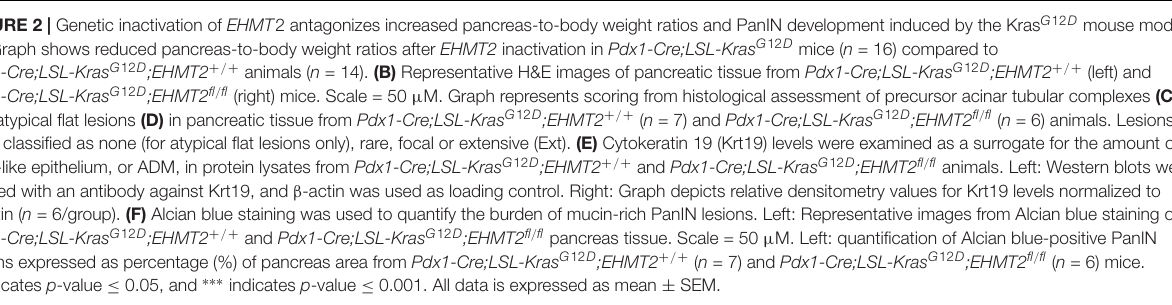
FIGURE 2 | Genetic inactivation of EHMT 2 antagonizes increased pancreas-to-body weight ratios and PanIN development induced by the Kras G 12 D mouse model. (A) Graph shows reduced pancreas-to-body weight ratios after EHMT2 inactivation in Pdx1-Cre;LSL-Kras G 12 D mice ( n = 16) compared to Pdx1-Cre;LSL-Kras G 12 D ;EHMT2 + / + animals ( n = 14). (B) Representative H&E images of pancreatic tissue from Pdx1-Cre;LSL-Kras G 12 D ;EHMT2 + / + (left) and Pdx1-Cre;LSL-Kras G 12 D ;EHMT2 fl / fl (right) mice. Scale = 50 µ M. Graph represents scoring from histological assessment of precursor acinar tubular complexes (C) and atypical flat lesions (D) in pancreatic tissue from Pdx1-Cre;LSL-Kras G 12 D ;EHMT2 + / + ( n = 7) and Pdx1-Cre;LSL-Kras G 12 D ;EHMT2 fl / fl ( n = 6) animals. Lesions were classified as none (for atypical flat lesions only), rare, focal or extensive (Ext). (E) Cytokeratin 19 (Krt19) levels were examined as a surrogate for the amount of duct-like epithelium, or ADM, in protein lysates from Pdx1-Cre;LSL-Kras G 12 D ;EHMT2 + / + and Pdx1-Cre;LSL-Kras G 12 D ;EHMT2 fl / fl animals. Left: Western blots were probed with an antibody against Krt19, and β -actin was used as loading control. Right: Graph depicts relative densitometry values for Krt19 levels normalized to β -actin ( n = 6/group). (F) Alcian blue staining was used to quantify the burden of mucin-rich PanIN lesions. Left: Representative images from Alcian blue staining on Pdx1-Cre;LSL-Kras G 12 D ;EHMT2 + / + and Pdx1-Cre;LSL-Kras G 12 D ;EHMT2 fl / fl pancreas tissue. Scale = 50 µ M. Left: quantification of Alcian blue-positive PanIN lesions expressed as percentage (%) of pancreas area from Pdx1-Cre;LSL-Kras G 12 D ;EHMT2 + / + ( n = 7) and Pdx1-Cre;LSL-Kras G 12 D ;EHMT2 fl / fl ( n = 6) mice. ∗ indicates p -value ≤ 0.05, and ∗∗∗ indicates p -value ≤ 0.001. All data is expressed as mean ±